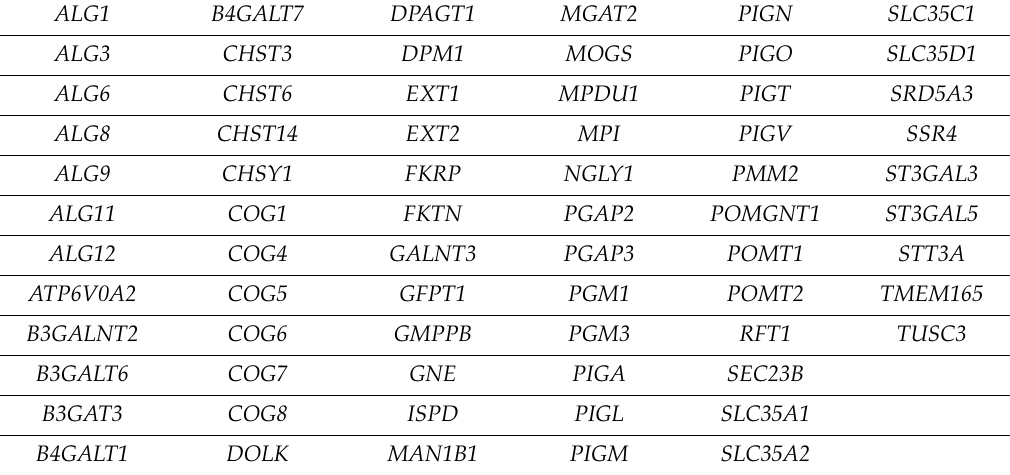
Table 4. Genes associated with congenital disorder of glycosylation (CDG), used in the clinical exome sequencing. CDG may be a cause of metabolic cardiomyopathy in the